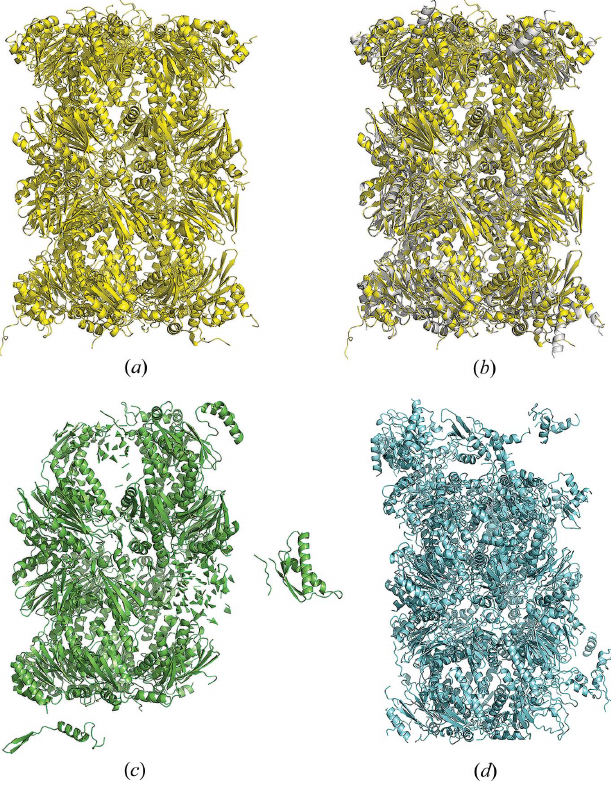
Method comparison, case study 2. ( a ) Model from IPCAS ; ( b ) model from IPCAS superimposed with the crystal structure (PDB entry 5lf7); ( c ) model from Phenix.AutoBuild ; ( d ) model from Buccaneer